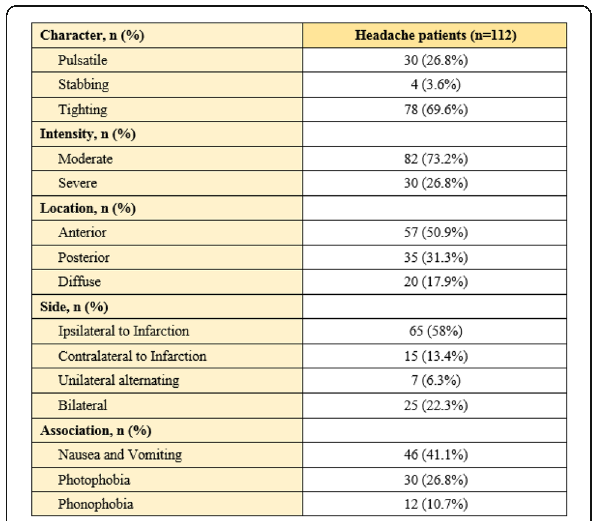
Fig. 2 (abstract P65). See text for description.